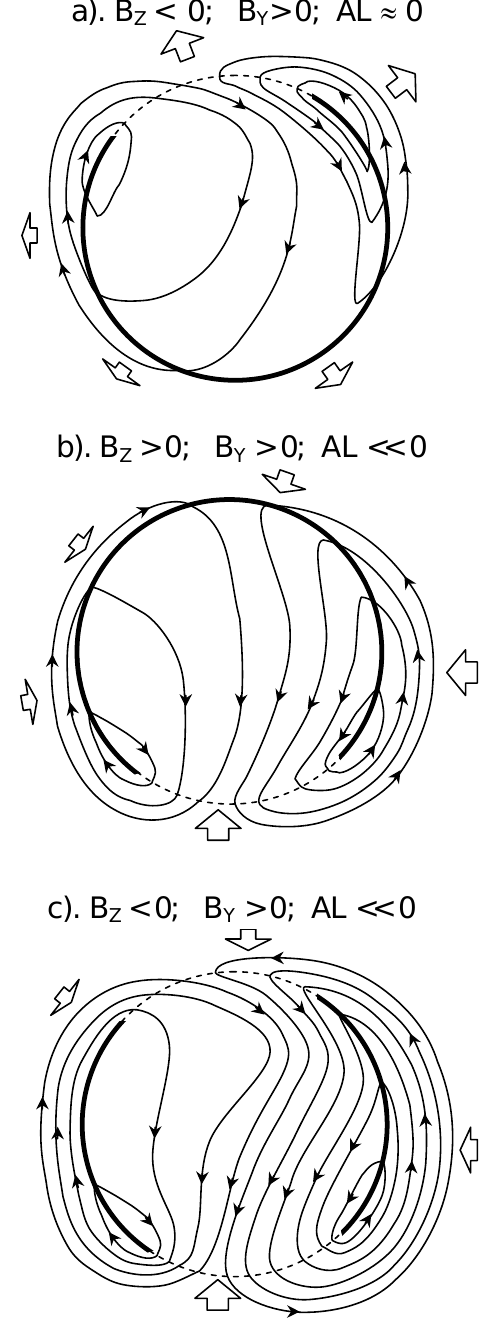
Fig. 4. Schematic of polar cap expansions and contractions. Lines with arrows are flow streamlines, thick solid lines are adiaroic (non- reconnecting) open closed field line boundary and dashed lines are footprints of the active dayside and nightside reconnection sites (in the magnetopause and cross-tail current sheet, respectively). Open arrows show the motion of the open-closed boundary. (a) Growth phase with IMF B z < 0, B Y > 0, and AL ≈ 0. (b) Expansion-recovery phase with northward IMF: B Z > 0, B Y > 0, AL (cid:28) 0. (c) Expansion- recovery phase with southward IMF: B Z < 0; B Y > 0; AL (cid:28)